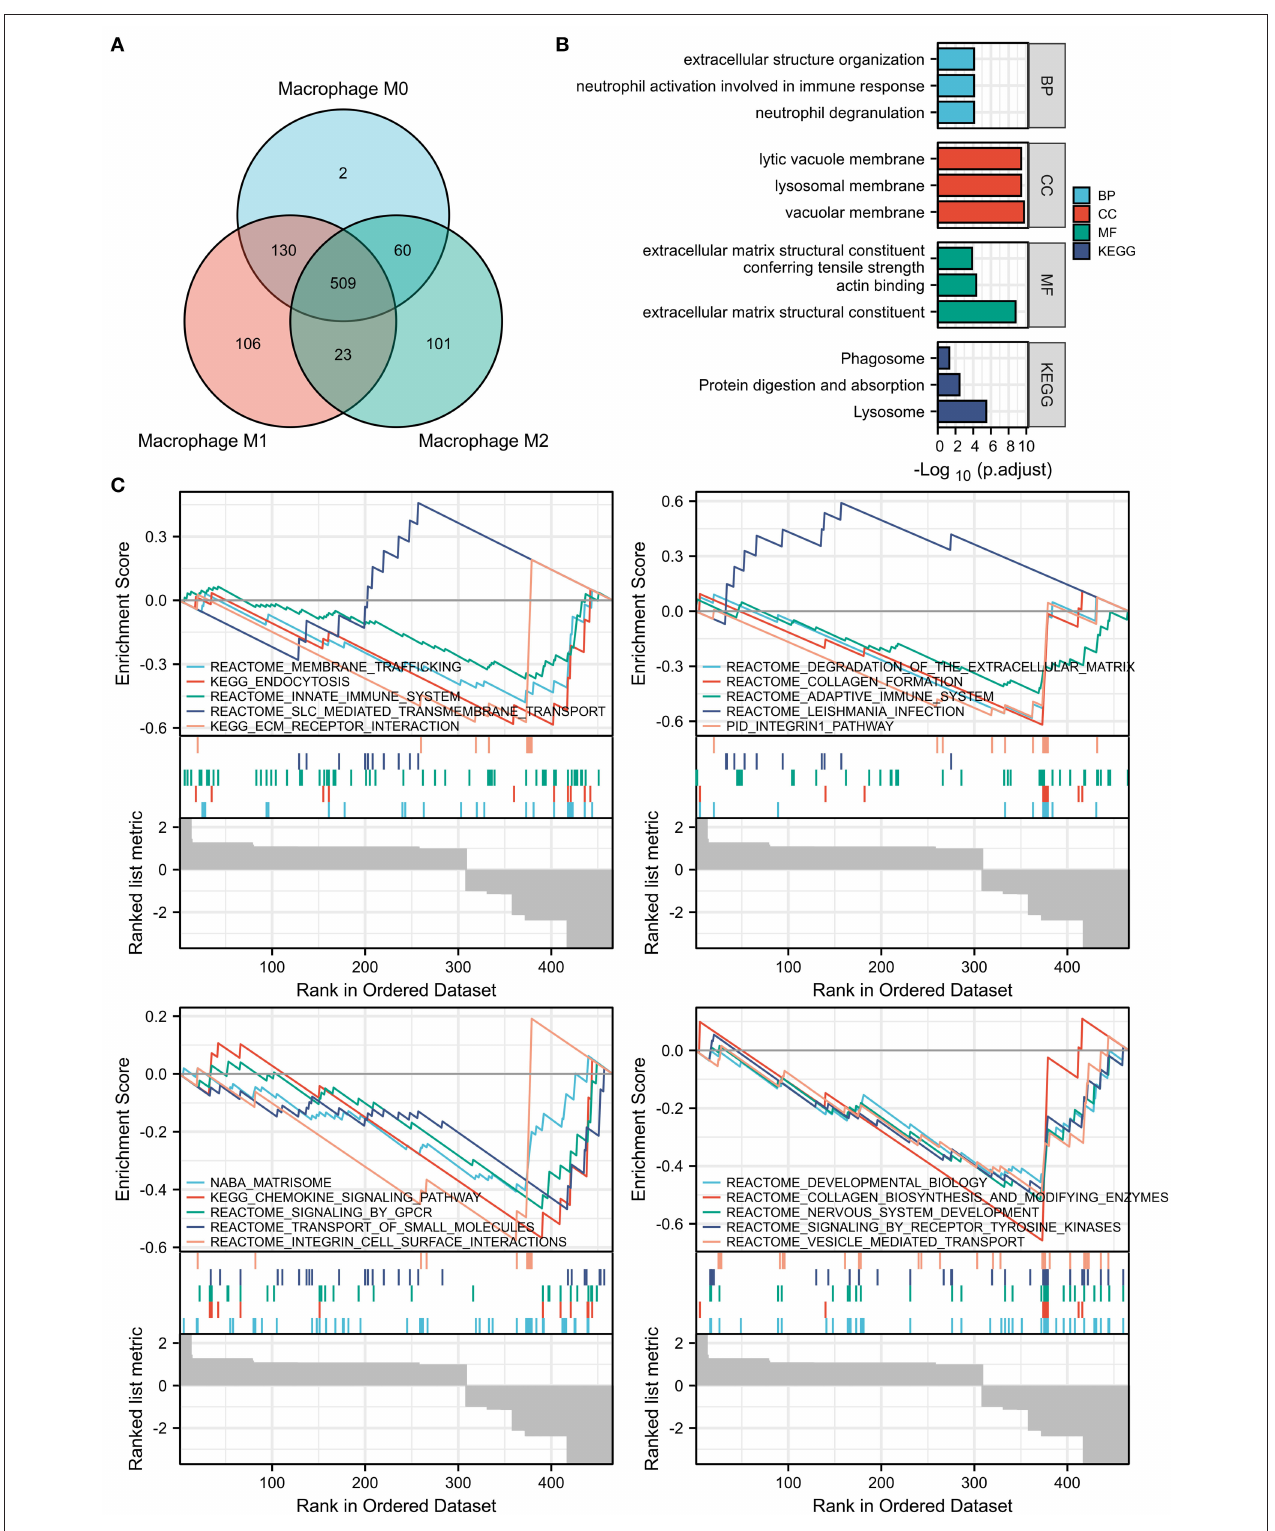
FIGURE 2 | Enrichment pathway analysis of the DEMRGs. (A) Venn diagram showed 509 differentially expressed genes (DEGs) among M0, M1, and M2 macrophages were regarded as DEMRGs. (B) The significant Gene Ontology (GO) and Kyoto Encyclopedia of Genes and Genomes (KEGG) pathways enriched by DEMRGs. (C) The gene sets associated with DEMRGs using Gene Set Enrichment Analysis (GSEA) analysis. DEMRGs, differentially expressed macrophages-related genes.